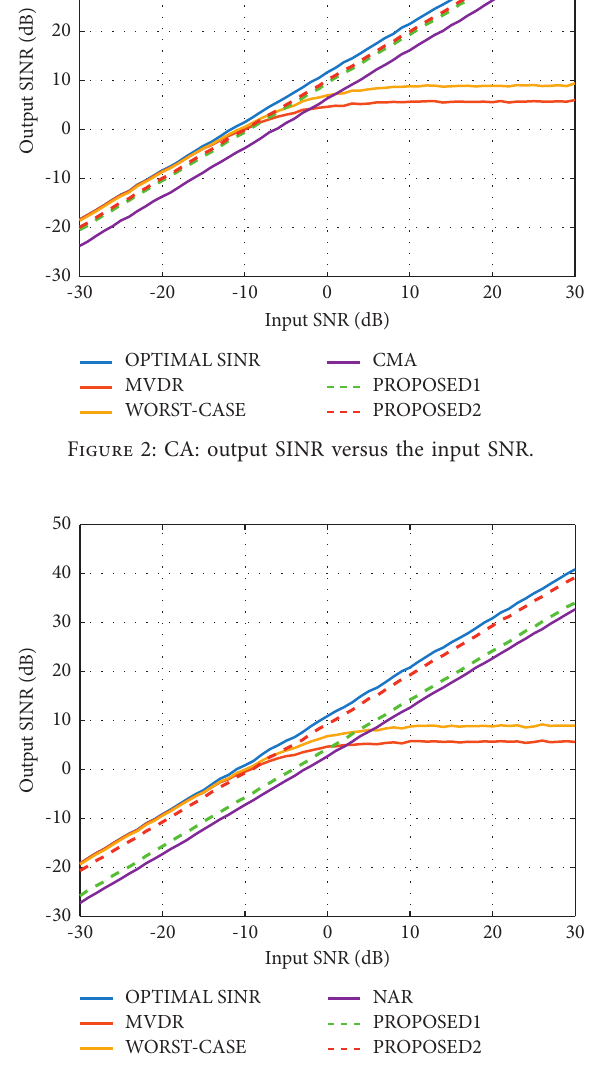
Figure 5: Received signal coherence: output SINR versus the input